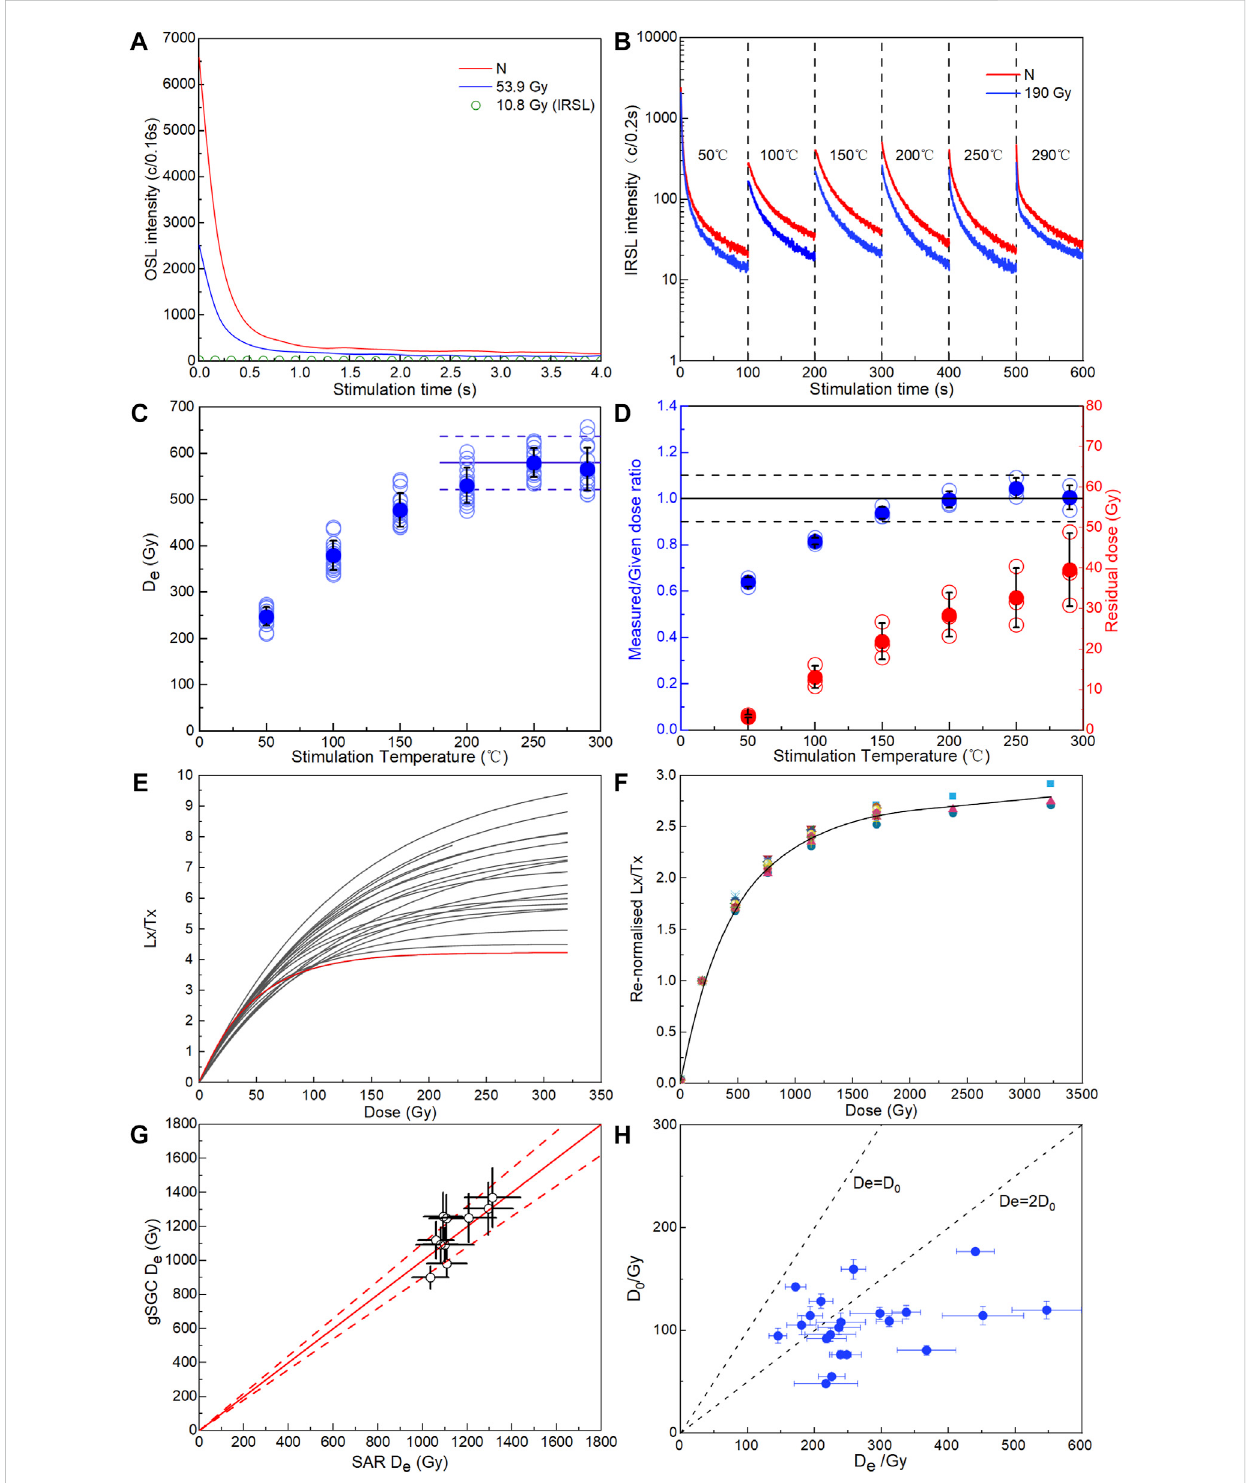
FIGURE 3 (A) OSL decay curves (HLG5-1). (B) Decay curves of MET-pIRIR signals (HLG5-1). (C) D e s at different stimulation temperatures (HLG5-1). (D) Dose recovery testof237 Gy (blue)forMET-pIRIRprotocolsandresidualdosesafter sunlight bleachedunderdifferentstimulationfortheMET-pIRIRsignals of sample HLG5-2 (red). (E) All SAR dose response curves (DRCs) of measured quartz aliquots, which displayed different saturation levels. The lowest red curve displayed the aliquot with the lowest D 0 of only 48 Gy. (F) Renormalized DRCs (dots) and gSGC (solid line) of KF. (G) Comparisons of SAR D e s and gSGC D e s. (H) Relation of D e versus D 0 in quartz